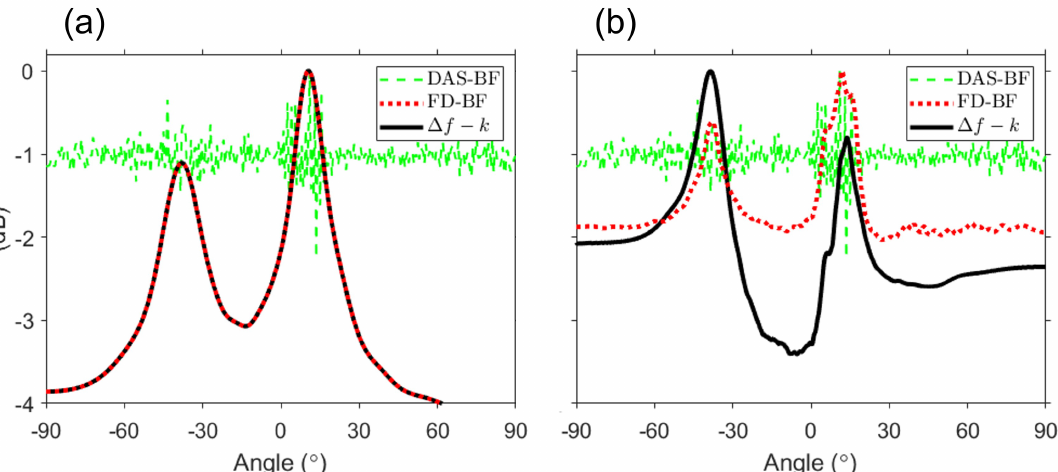
Figure 9. For experimental data, comparison of the ∆ f – k analysis (black solid line) with FD beamforming (red dotted line) double-averaged over 0 ∆ f ( a ) 200 Hz (design frequency) or ( b ) 1400 Hz ≤ ≤ with DAS beamforming (green dashed line). In ( b ), contrary to the expected result ( a ), not only are the sidelobes reduced but also the intensity of the direct path is lower than that of the surface-reflected path. Angle spread, which deteriorates at difference frequencies above 400 Hz, causes destructive interference. Consequently, as double-averaging the direct path includes a wider angle–spread region, the intensity is relatively lower than that of the surface-reflected path.